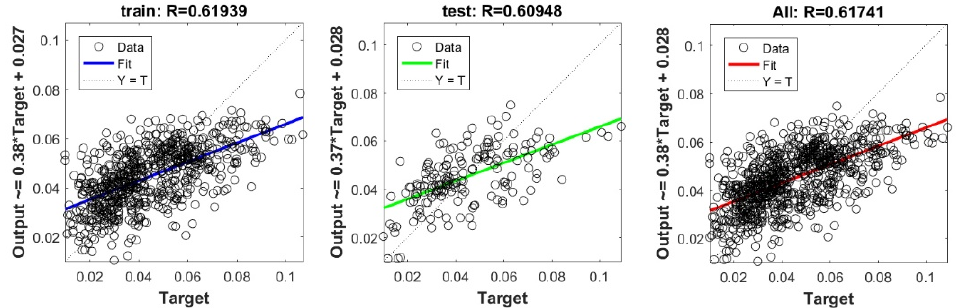
Figure A19. Scatter plots between target and output value by the GT-Step model.